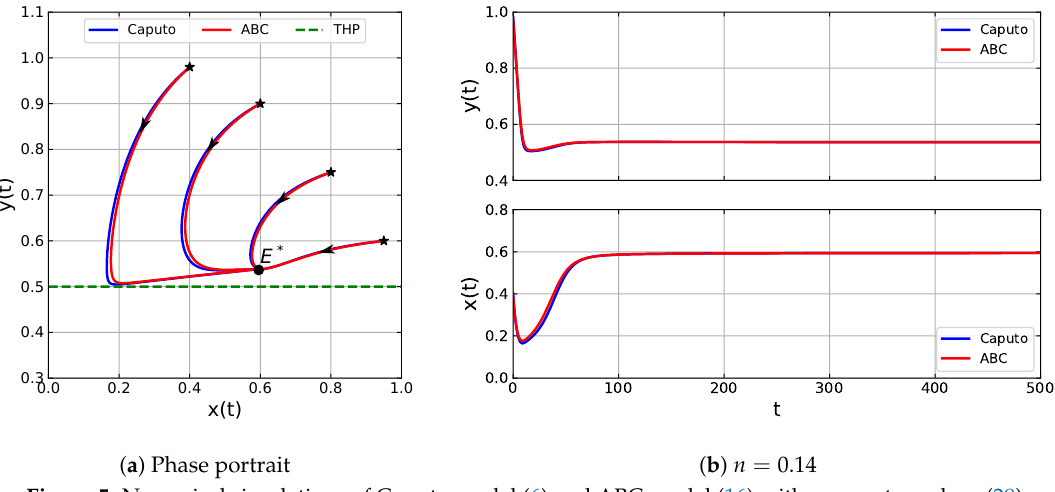
Figure 5. Numerical simulations of Caputo model (6) and ABC model (16) with parameter values (29), n = 0.2 and T = 0.5.